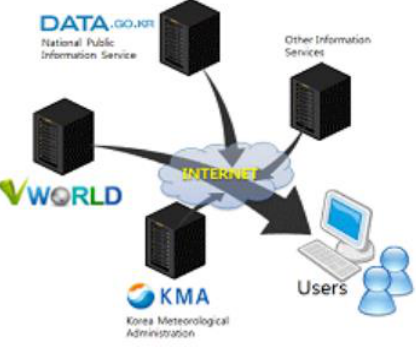
Figure 10. Mash-up Application Model